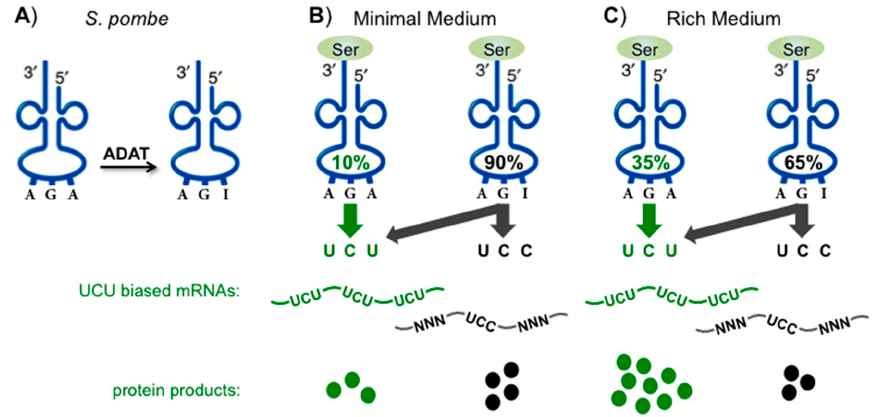
Figure 3. Differentially modified adenosine-34 to inosine-34 (I34) in tRNA Ser A/IGA may be keyed to synonymous codon splitting in the fission yeast, Schizosaccharomyces pombe . ( A ) The enzyme adenosine deaminase acting on tRNA (ADAT) converts A34 in tRNAs to I34, shown here for tRNA Ser A/IGA; ( B ) In minimal medium, the relative amounts of tRNA Ser AGA and tRNA Ser IGA are 10% and 90% as indicated in the tRNA cartoon [94]. The downward vertical arrows reflect relative efficacy of the AGA and IGA anticodons for UCU and UCC codons; IGA can decode both UCU and UCC codons whereas media produces faster growth and requires high levels of protein synthesis, including production of ribosomal proteins whose mRNAs are highly abundant and are enriched/biased in UCU codons and lack UCC codons (see text). As the percentage of unmodified tRNA Ser AGA increases in rich media those tRNAs are directed to the UCU-biased mRNAs because without I34 they cannot readily decode the UCC containing mRNAs (see